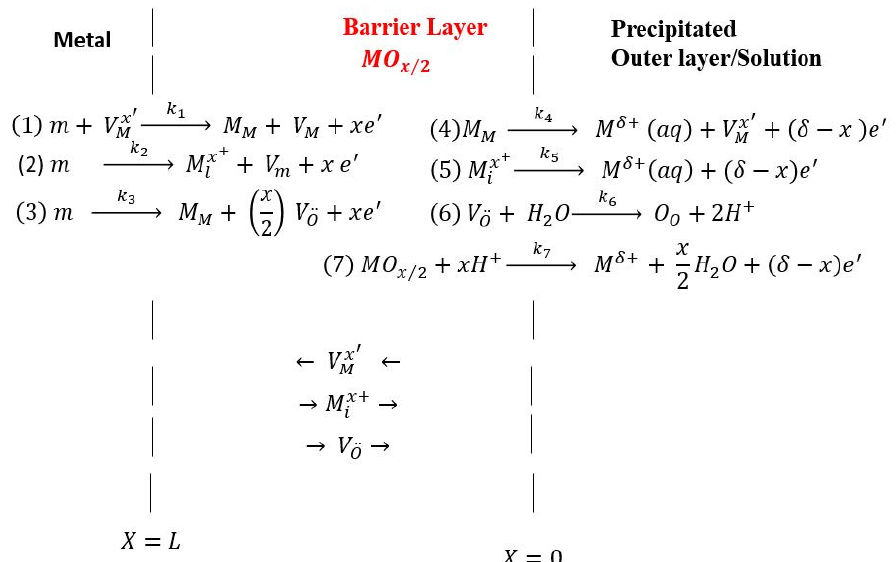
Figure 1. Summary of the defect generation and annihilation reactions proposed to take place at the interfaces of the barrier oxide layer on metal, according to the PDM. m and V x (cid:48) represent the metal atom and cation vacancy on the cation sublattice of the barrier layer, respectively. M x + is a cation interstitial, V .. is an oxygen (anion) vacancy, M δ + ( aq ) is a cation at the outer layer/solution interface, and M M and V m are the metal cation on the cation sublattice of the barrier layer and a vacancy in the modified martensitic stainless steel (MMSS) sample, respectively. O O is an oxide ion in the anion site on the anion sublattice, and MO x /2 is the stoichiometric barrier layer oxide. Note that the origin of the coordinate system is the bl/s interface, and hence that the flux of oxygen vacancies is